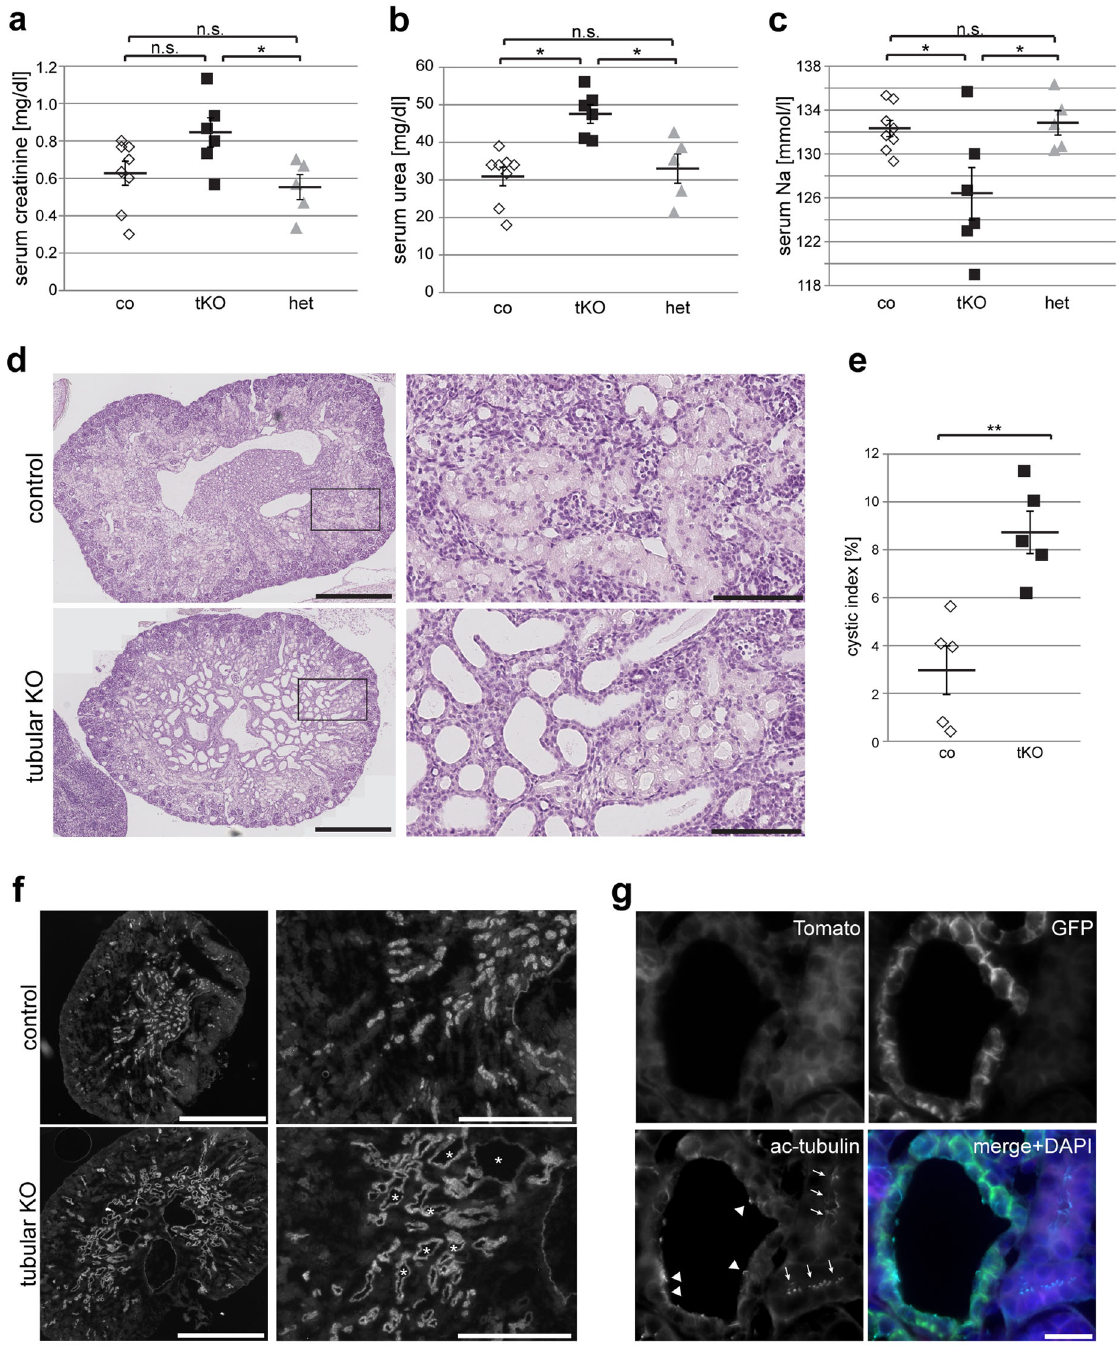
Fig. 2 Deletion of Ruvbl1 in the distal nephron leads to acute kidney injury. a – c On day P1, newborn Ruvbl1 tubular knockout animals (tKO; n = 8) showed overall signi fi cantly increased serum creatinine levels (F(2, 16) = 4.158, p = 0.04; Tukey ’ s post hoc * p < 0.05) ( a ), signi fi cantly increased serum urea levels (F(2, 16) = 9.953, p = 0.002; Tukey ’ s post hoc * p < 0.05, ** p < 0.01) ( b ), and signi fi cantly reduced serum sodium levels (F(2, 16) = 5.472, p = 0.02; Tukey ’ s post hoc * p < 0.05) ( c ) compared with control (co; n = 6) or heterozygous (het; n = 5) littermates. Mean ± SEM. d Histological PAS staining of control and Ruvbl1 tubular knockout kidneys of newborn mice showing dilated renal tubules in Ruvbl1 tubular knockout animals. Scale bars: 500 µm (left) and 100 µm (right). e The cystic Index was signi fi cantly increased in Ruvbl1 tubular knockout (tKO) kidneys (t(8) = 4.280, ** p < 0.01). Mean cystic index ± SEM. f Immuno fl uorescence staining showing that the cystic tubules in tubular Ruvbl1 knockout animals were restricted to Aqp2-positive (collecting duct) sections of the nephron (*). Scale bars: 1 mm (left) and 500 µm (right). g After crossing in the mTmG reporter mouse line, GFP-expressing dilated tubules showed few ciliated (arrow heads) epithelial cells compared with neighboring GFP-negative tubules (arrows) in tubular knockout mice ( Ruvbl1 fl / fl Ksp:Cre + R26mTmG tg ). Scale bar: 20